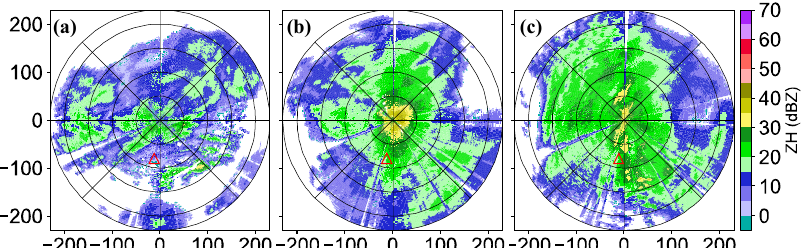
Figure 8. The 0.5° PPI of reflectivity of the Hefei radar at 0726 ( a ), 0127 ( b ), and 1332 LST ( c ) on 26 January 2020, in which the red triangle is the location of the disdrometer at Lujiang, and the scale on the coordinate axes represents the distance (km).